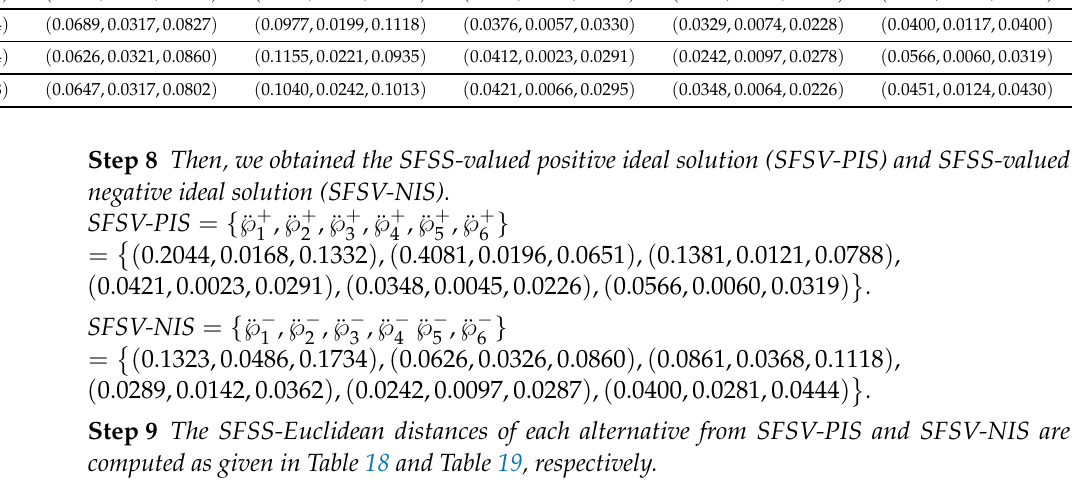
Table 18. Positive ideal